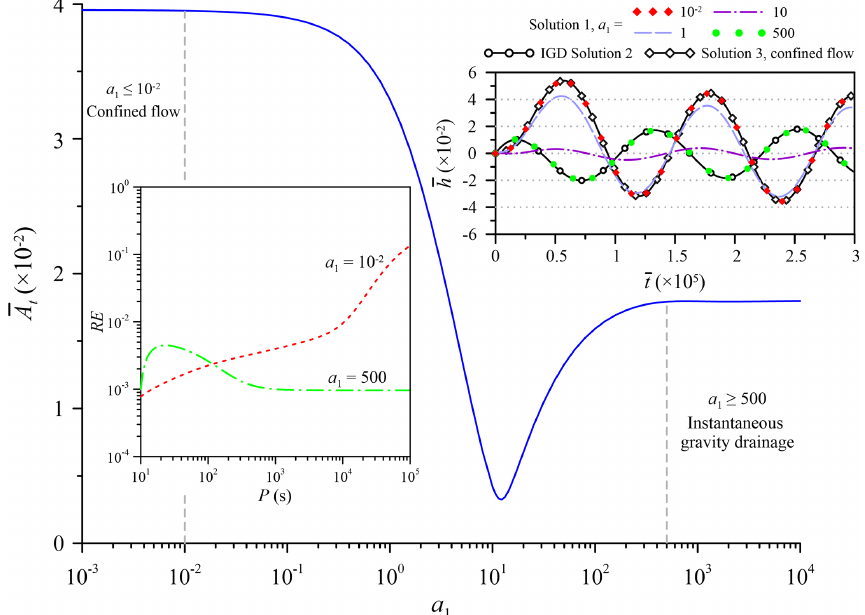
Figure 2. Influence of delayed gravity drainage on the dimensionless amplitude A t and transient head h at r = 1, z = 1, predicted by Solution 1 for different magnitudes of a 1 related to the influence.